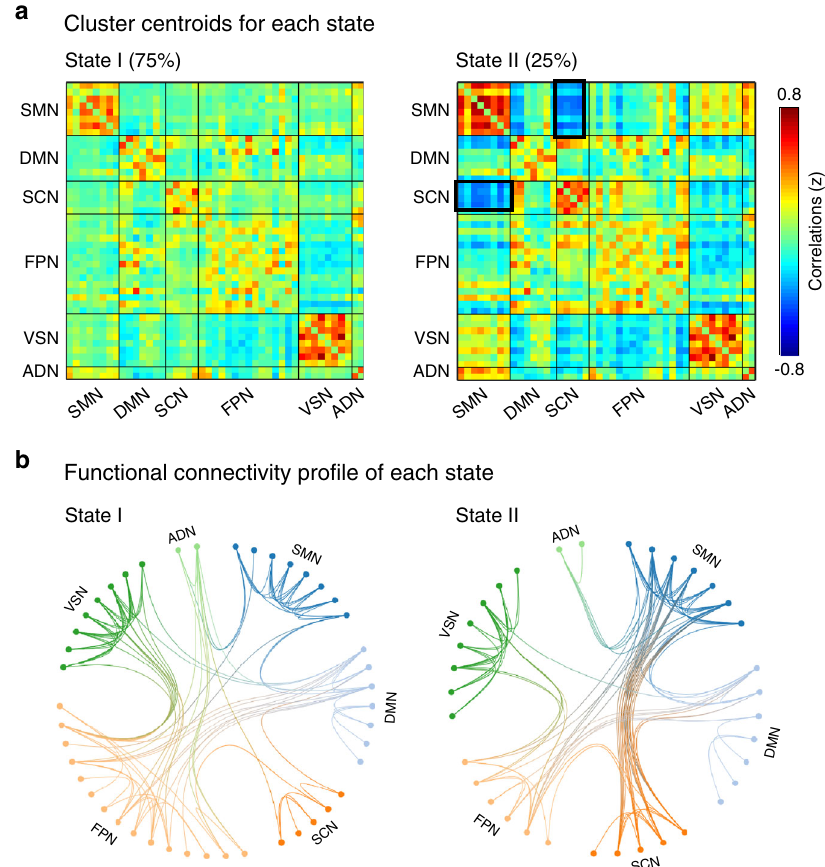
Fig. 2 Findings of clustering analysis. a Cluster centroids of each state. Two states, a more frequent (around 75% of total occurrences) and sparsely connected State 1, and a less frequent (around 25% of total occurrences) and more strongly interconnected State 2. b Top 100 of the functional connectivity in each state, representing the strongest connections (i.e., the absolute value of correlation coef fi cients). Each color represents one of the six networks. Between-network connections were indicated by a transition of colors between the two